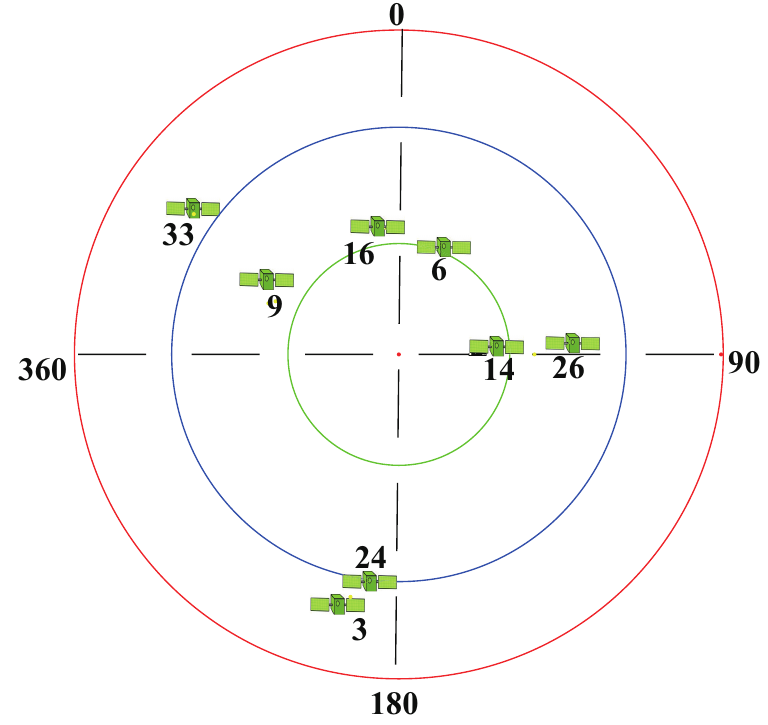
Figure 9. BeiDou satellite skyplot at the data collection time in the first experiment. The latitude and longitude are 39.69 ◦ and 116.69 ◦